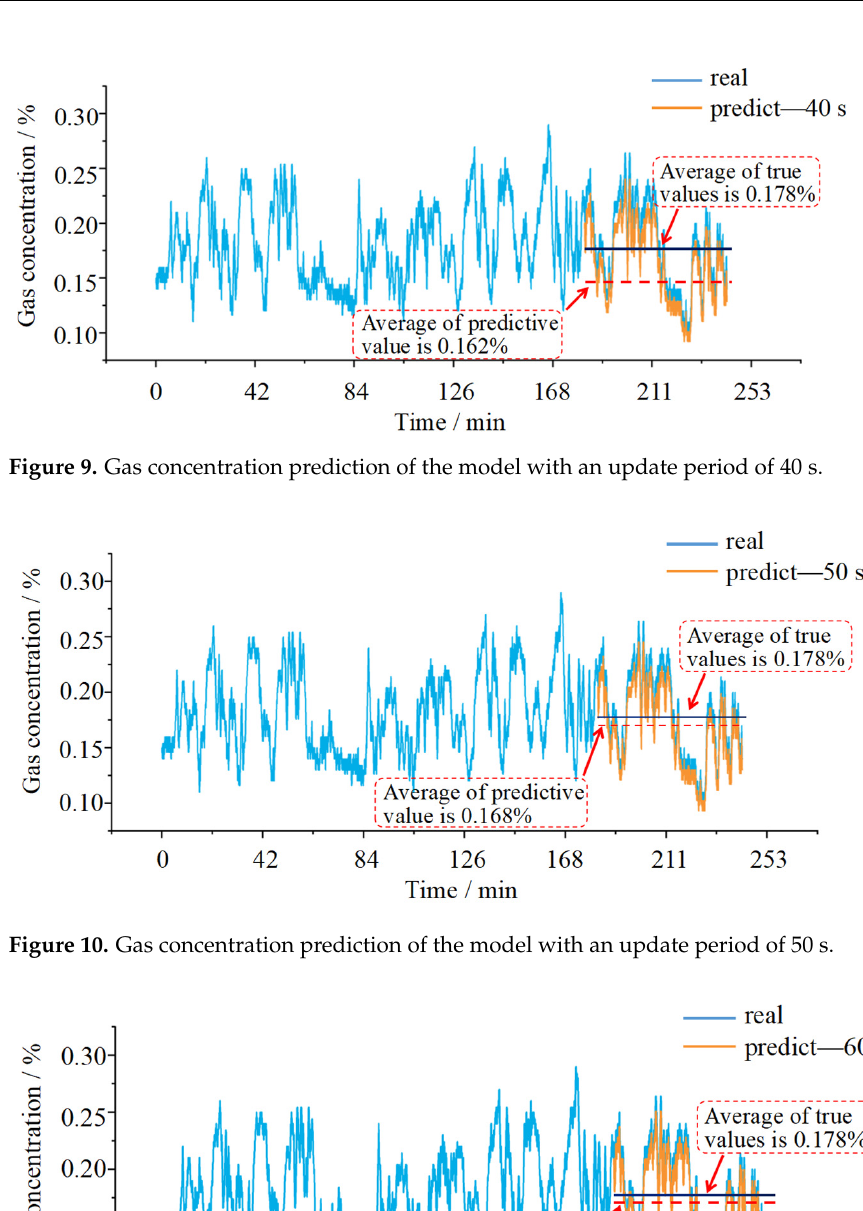
Figure 8. Gas concentration prediction of the model with an update period of 30 s.